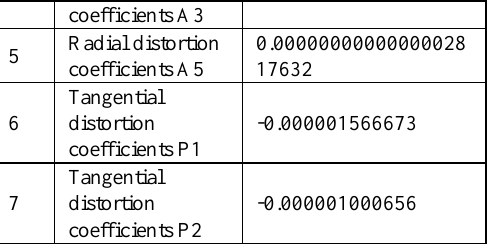
Table 1. Calibrated parameters of